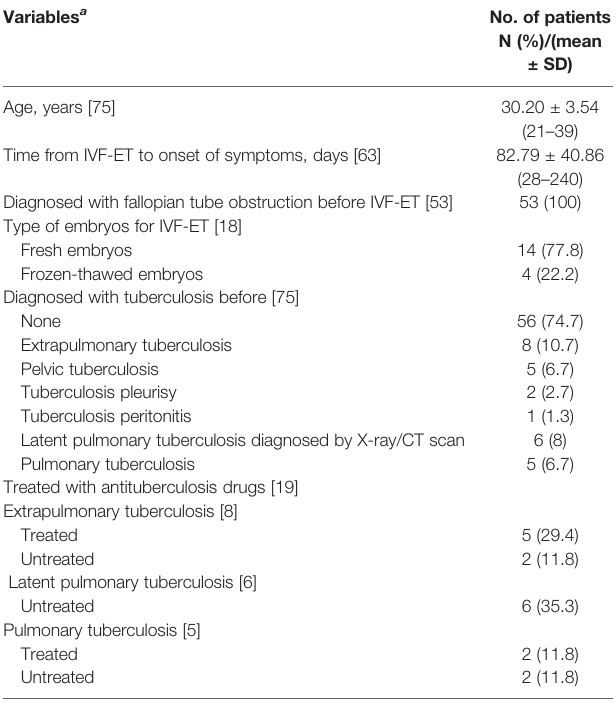
TABLE 2 | Demographic characteristics and past medical history in 75 patients diagnosed with miliary pulmonary tuberculosis after IVF-ET. Variables